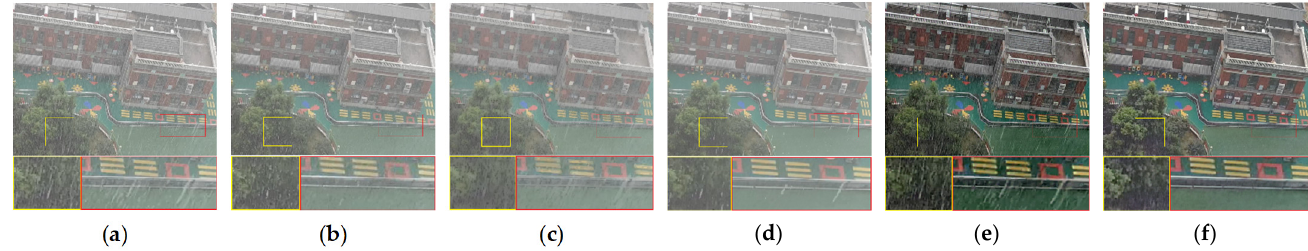
Figure 10. Comparison on a real snow video. ( a ) Input, ( b ) Kim et al. [16], ( c ) Wang et al. [8], ( d ) Li et al. [14], ( e ) Chen et al. [32], ( f ) proposed method.